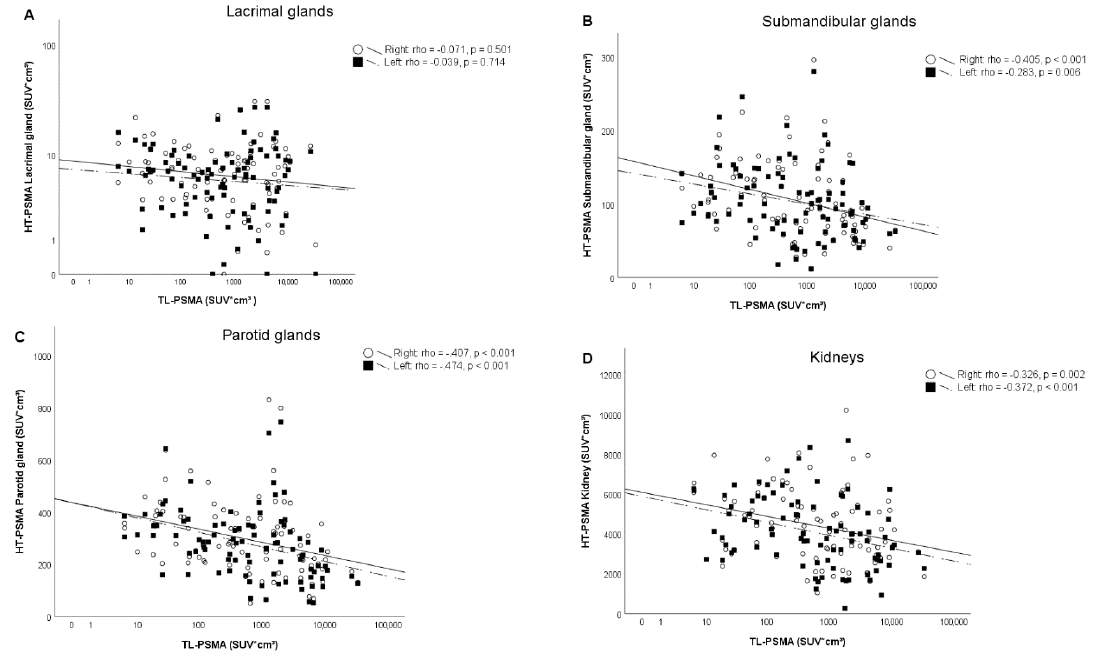
Table 2. Correlation outcomes of HT-PSMA and PSA. Figure 3. Correlation between the fractional uptake volume of [ 68 Ga]Ga-PSMA-11 in different healthy tissues (HT-PSMA) divided by side and the fractional total lesion [ 68 Ga]Ga-PSMA-11 uptake volume (TL-PSMA) in patients with metastatic prostate cancer. ( A ) Lacrimal glands; ( B ) submandibular glands; ( C ) parotid glands; and ( D ) kidneys. No correlation was found between the lacrimal glands and TL-PSMA. A weak–moderate correlation was found between the TL-PSMA and the submandibular- and parotid glands and kidneys, with a correlation coefficient of − 0.447, − 0.345, and − 0.394, respectively (when left and right side are combined). Rounds/continuous line represents the right side of the organ, squares/dashed line represents the left side of the organ, with the correlation coefficient of the separate sides presented in the upper right corner of each graph.